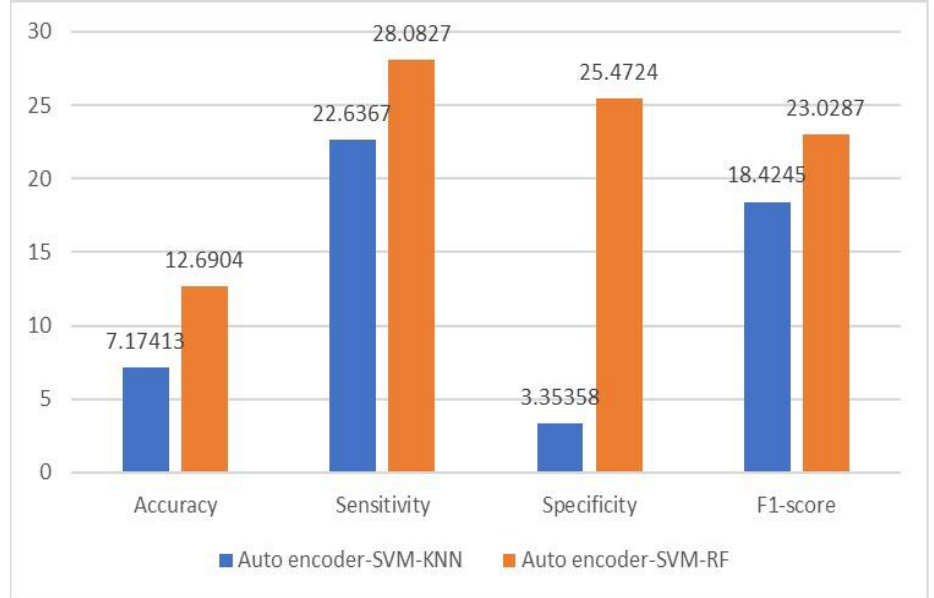
Figure 4. Improvement in performance parameters between algorithms .